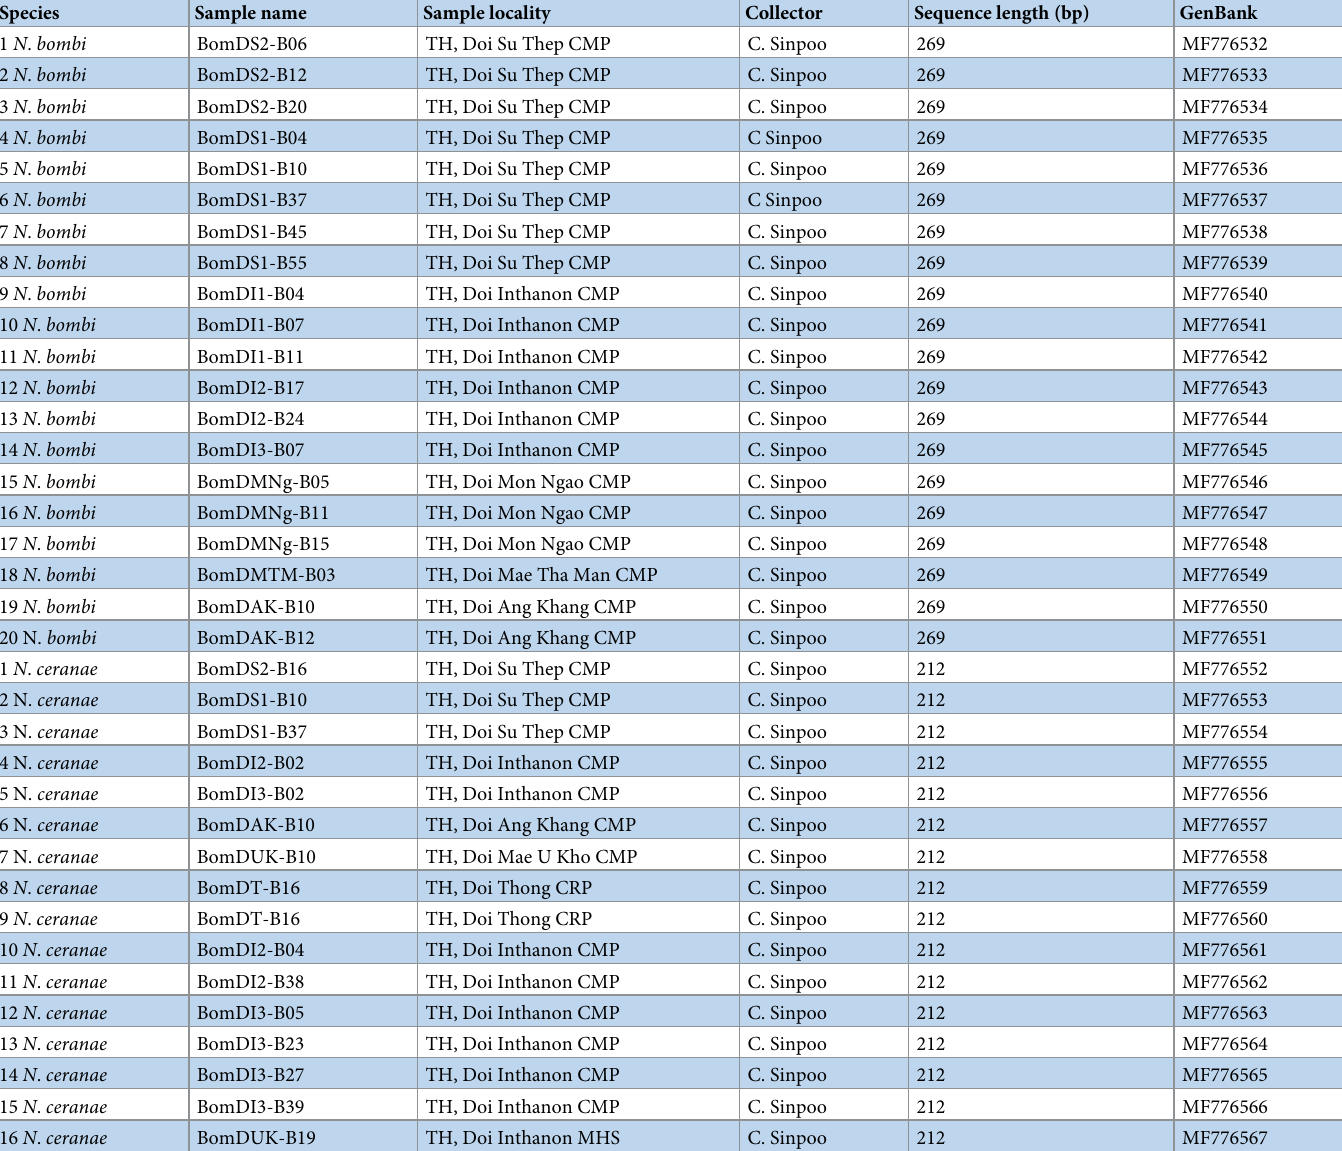
Table 6. Material used in the phylogenetic analysis with the sample locality, collector, sequence length, depository and GenBank accession number.